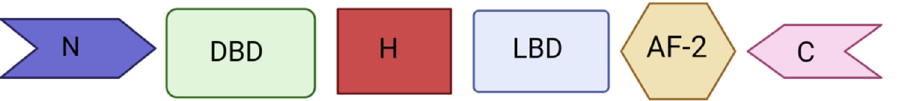
Figure 1. Structure of PXR protein. PXR consists of a ligand-depended activation function 2 (AF-2) and a highly conserved DNA-binding domain (DBD) in the N-terminal with two zinc-fingers while the DBD is connected to the C-terminal ligand binding domain (LBD) using a hinge .